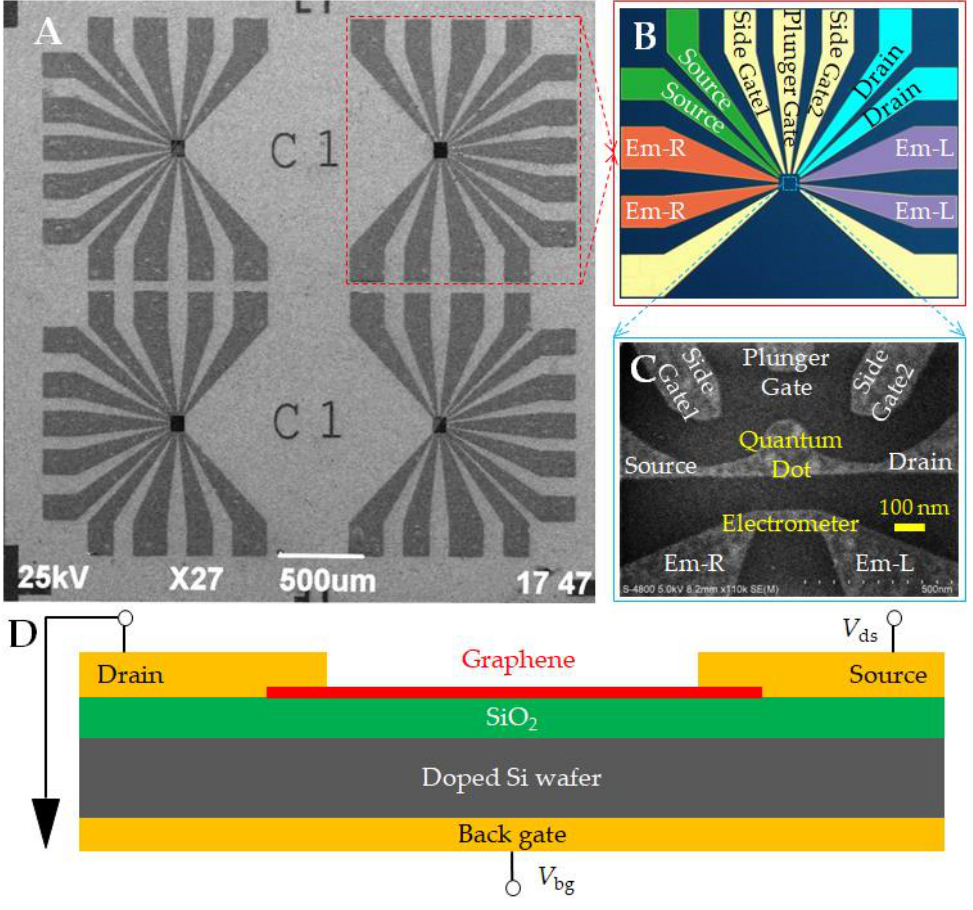
Figure 1. ( A ) SEM image of graphene quantum dot device chip; ( B ) electrode arrangement; ( C ) SEM image of quantum dot and nanostrip electrometer structure; and ( D ) device cross-section diagram. The source and drain are connected with the quantum dot via graphene nanoribbon.